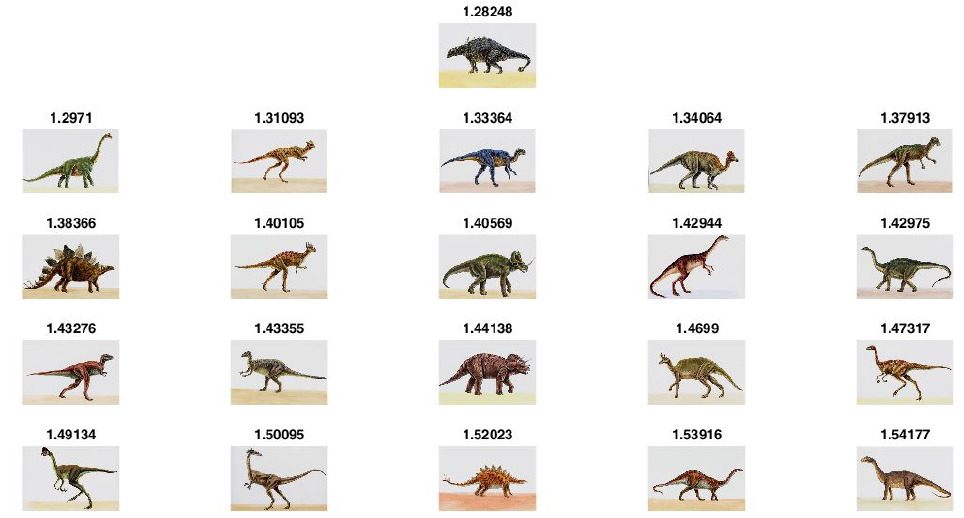
Figure 11. Result of image retrieval for the semantic class “Dinosaurs”.